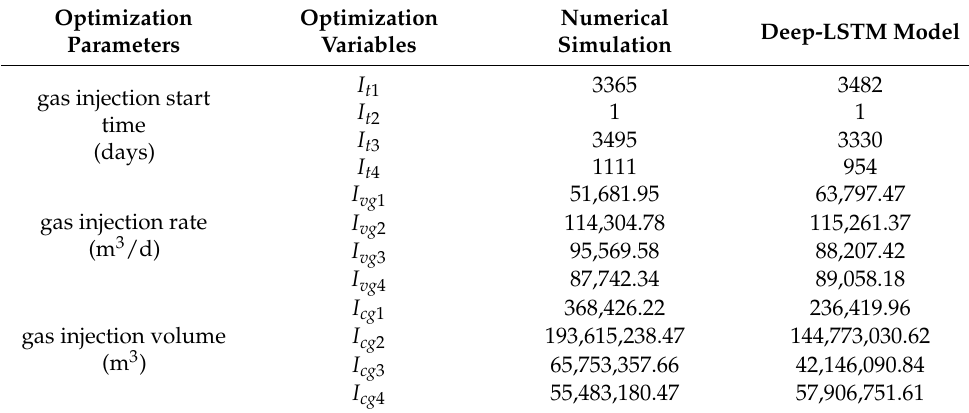
Table 7. Comparison of optimization results of 4 gas injection wells.